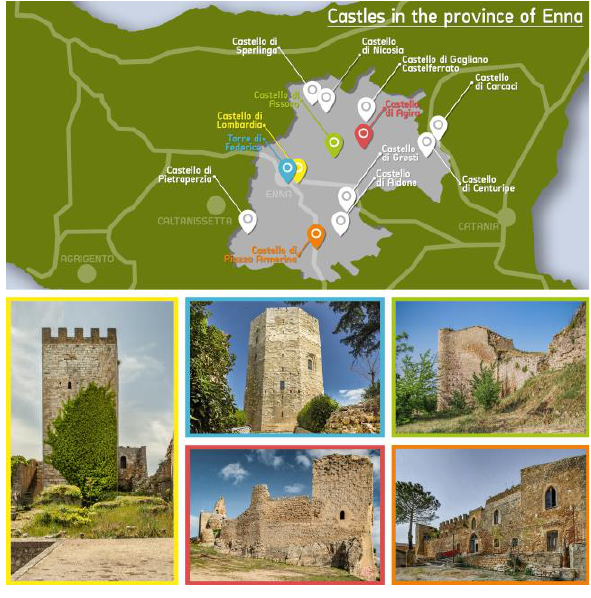
Figure 1. Some castles and towers in the province of